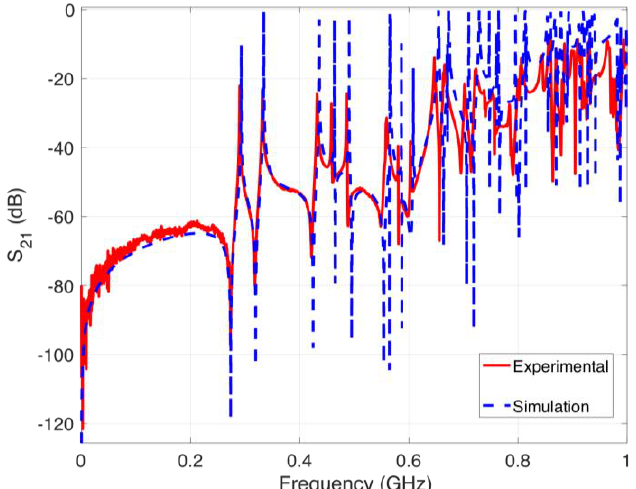
Figure 13. S21 parameter obtained using the experimental setup and the simulation scheme.